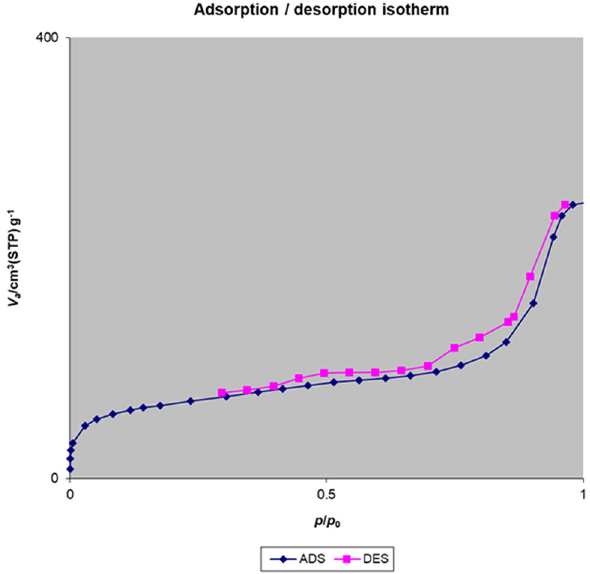
Figure 21. Nitrogen adsorption–desorption isotherm of the Fe 3 O 4 @Void@m.SiO 2 nanomaterial after adsorption process.